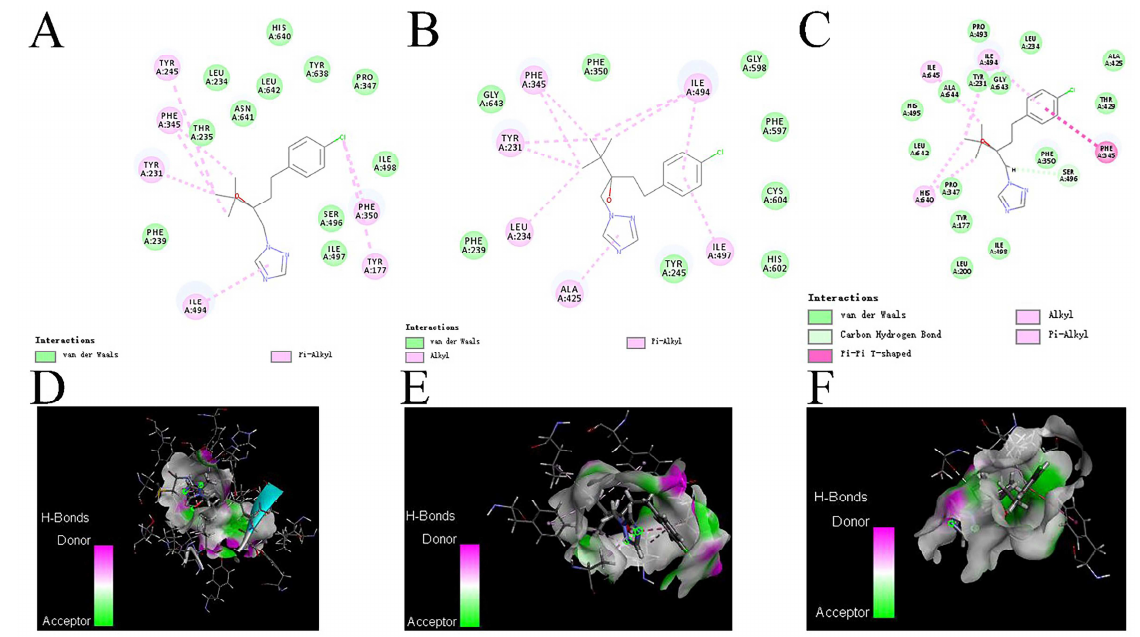
Figure 6. The interaction models for the CYP51-tebuconazole complex: ( A , D ) the interaction mod- els of CYP51 and tebuconazole in the susceptible isolates, respectively; ( B , E ) those of CYP51 S94A,N406S,H793R and tebuconazole, respectively; ( C , F ) those of CYP51 S94A,N406S,L750P,H793R and tebuconazole,